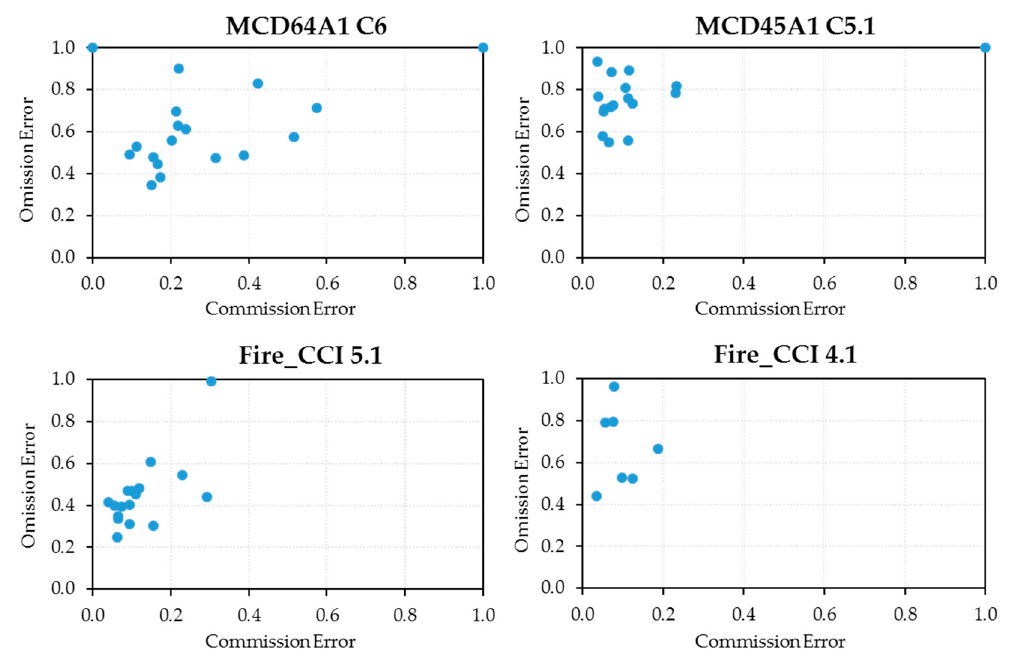
Figure 9. Scatterplots of annual omission errors versus annual commission errors for each of the four burned area products analyzed.